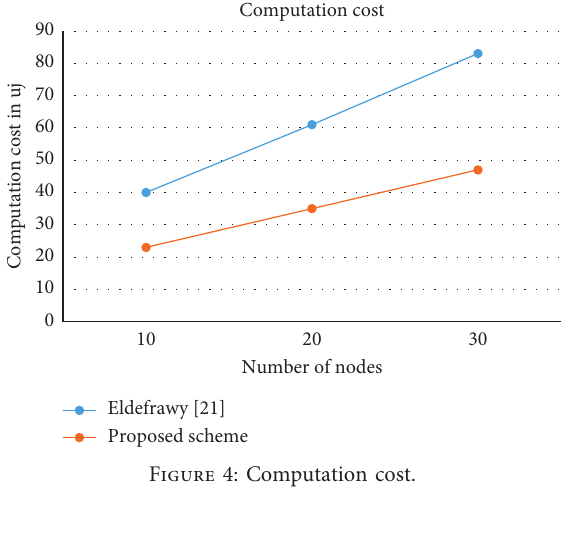
Figure 4: Computation cost.